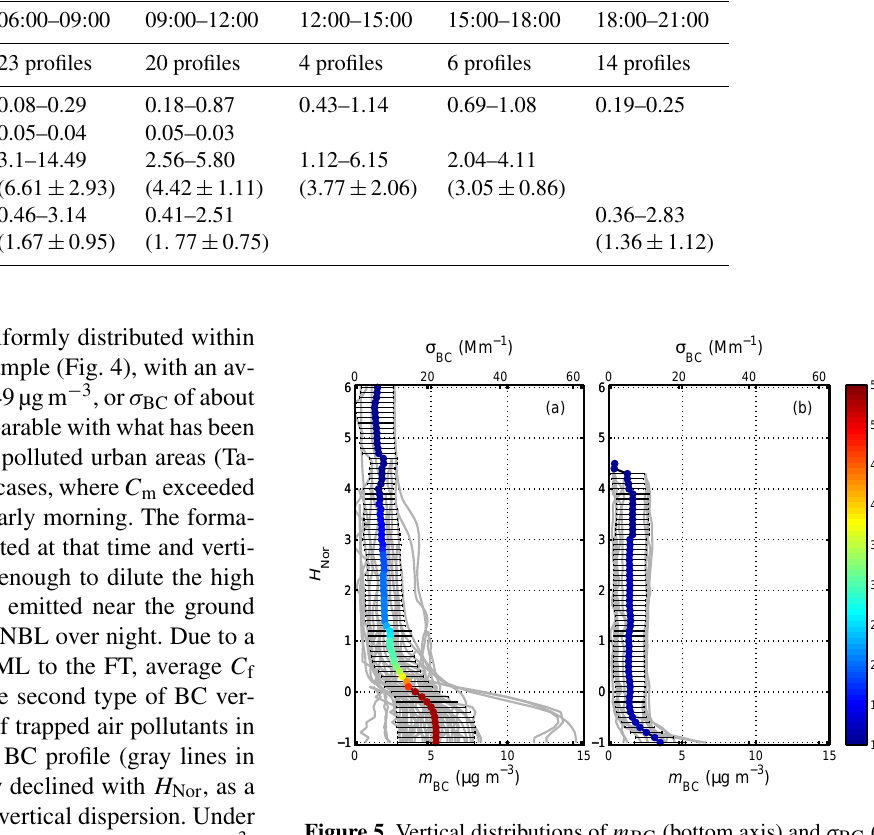
Figure 5. Vertical distributions of m BC (bottom axis) and σ BC (top axis) along the normalized height H Nor (a) in the daytime and (b) in the evening during the field campaign (gray lines). The average pro- file is shown by the black line, with error bars representing stan- dard deviations. Average values are indicated by dots, with the color showing the number of samples at each